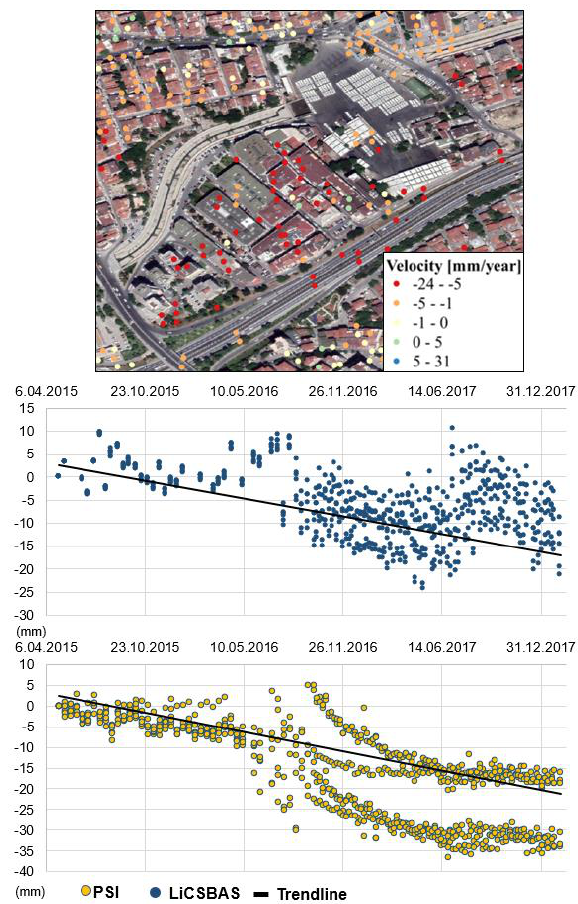
Figure 5. An example for unsuitable site with time series of the PSI and LiCSBAS method. The LOS time series is from the area shown by the red dots.